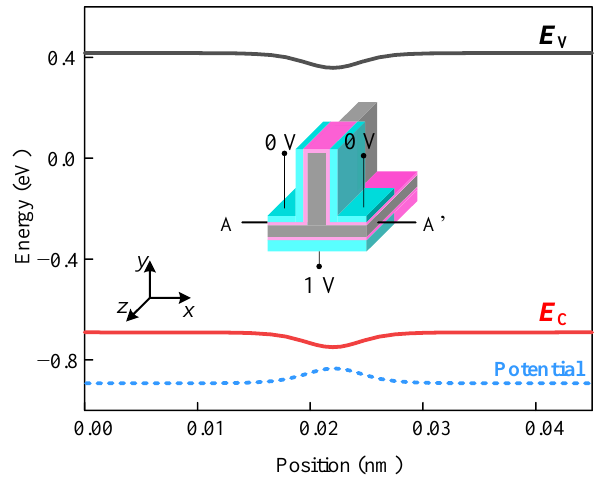
Figure 4. The potential and energy band distributions along cutline AA’ in x-axis. Using the above simplified approach, the potential distribution ( V RG = 1 V, V BG = 0 V) can be depicted as a straight line DF as shown in Figure 3b, where two similar triangles DEF and D’E’F’ can be obtained. Therefore, the simplified analytical model can be expressed as: V (cid:48) RG − V (cid:48) BG